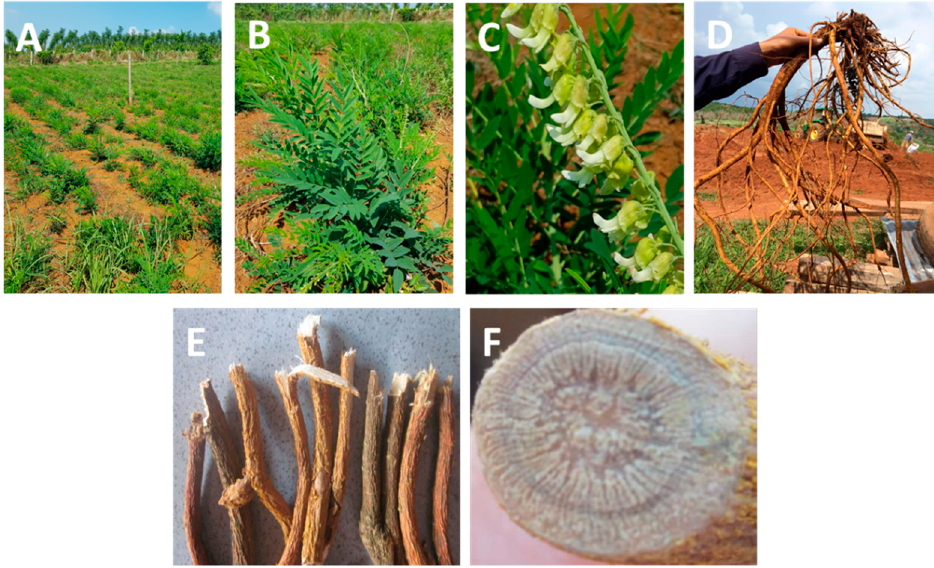
Figure 1. SFA samples. ( A ) SFA was cultivated in Dak Nong province, Vietnam. ( B ) SFA tree. ( C ) SFA flowers. ( D ) SFA roots. ( E ) SFA dry root samples. ( F ) Transverse section of SFA root.